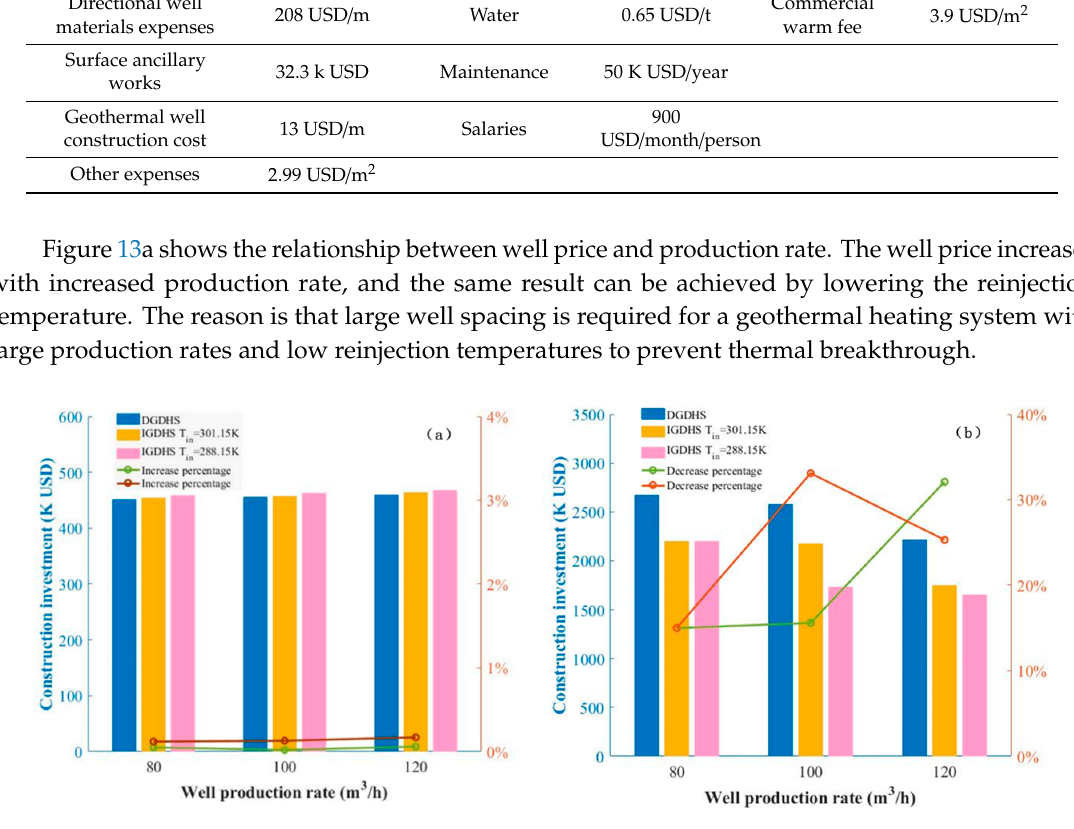
Figure 13. Well price and initial construction investment for geothermal wells of different heating modes: ( a ) construction price of directional well; ( b ) construction investment of heating system.